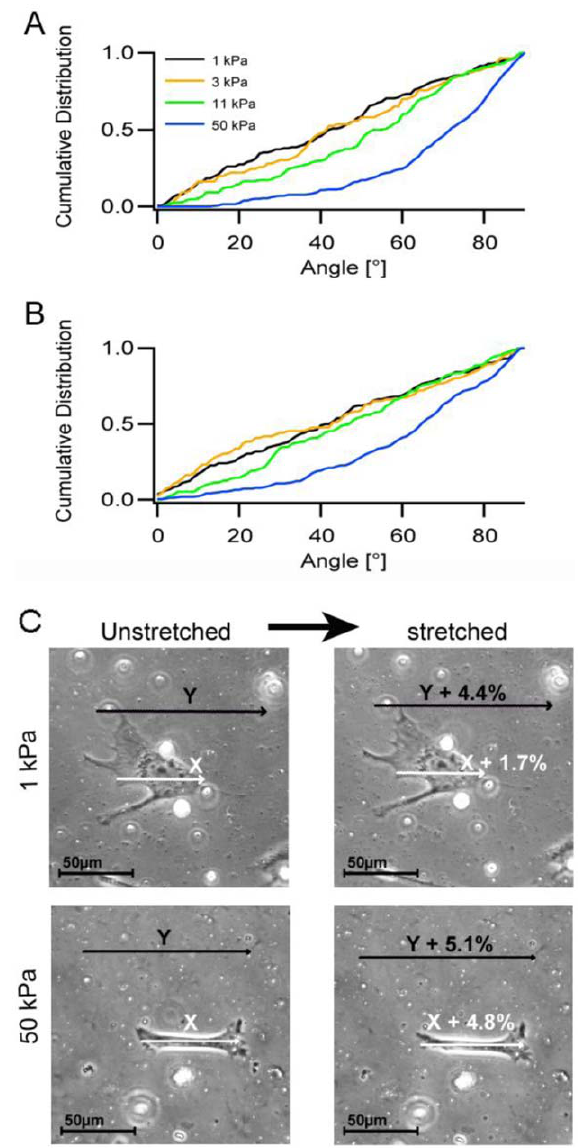
Figure 8. Effect of substrate elasticity on mechanoresponse induction. Cells on stretch chambers of , 1 kPa, 3 kPa, 11 kPa and 50 kPa elasticity were stretched for 16 hours with amplitude a 3 (11.8%). Subsequently, cells were fixed, stained for actin and main actin orientation angles (A) as well as main cell orientations (B) were determined. n equals 145, 86, 152 and 261 cells for Young’s moduli of , 1 kPa, 3 kPa, 11 kPa and 50 kPa, respectively. (C) Single cell analysis on cells grown on , 1 kPa and 50 kPa substrates, respectively, before and after the indicated substrate stretch (Y, black arrow). Substrate elongations under the cell (X, white arrow) were determined. The indicated percentage is the effective substrate elongation. Note the strongly reduced substrate stretch under the cell on , 1 kPa substrates. n=2 cells on , 1 kPa substrate and 3 cells on 50 kPa substrate.